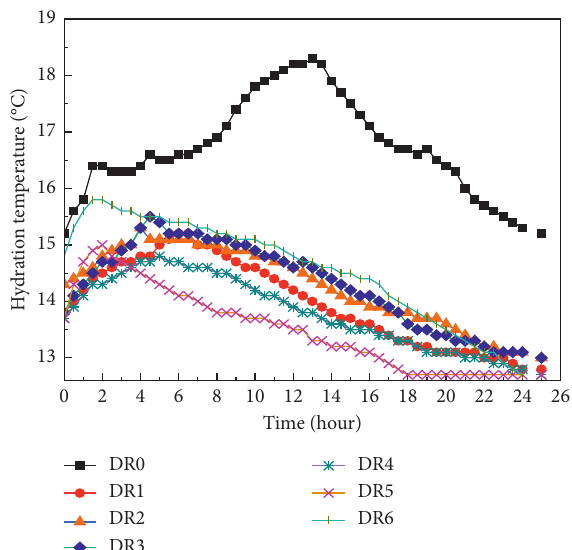
Figure 4: Test result of hydration temperature of the SFCC paste.